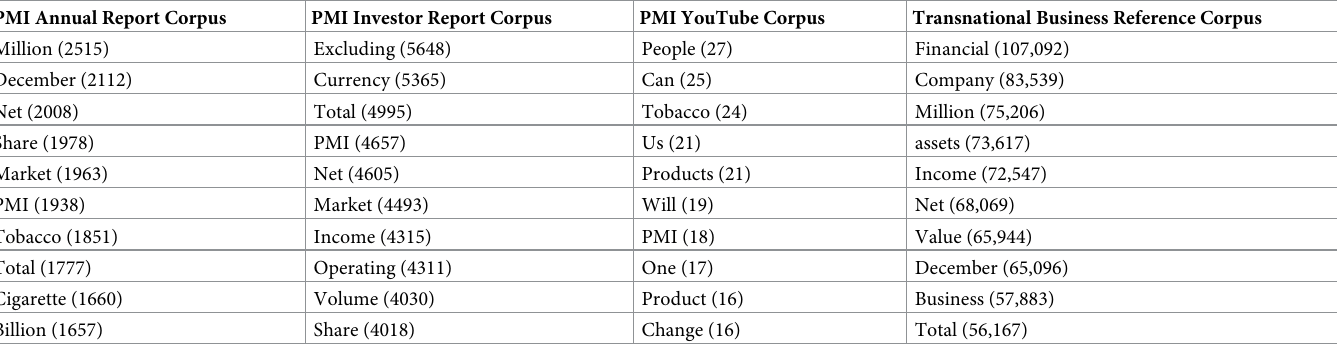
Table 3. Most common words in sample and reference corpora ranked in descending order of frequency